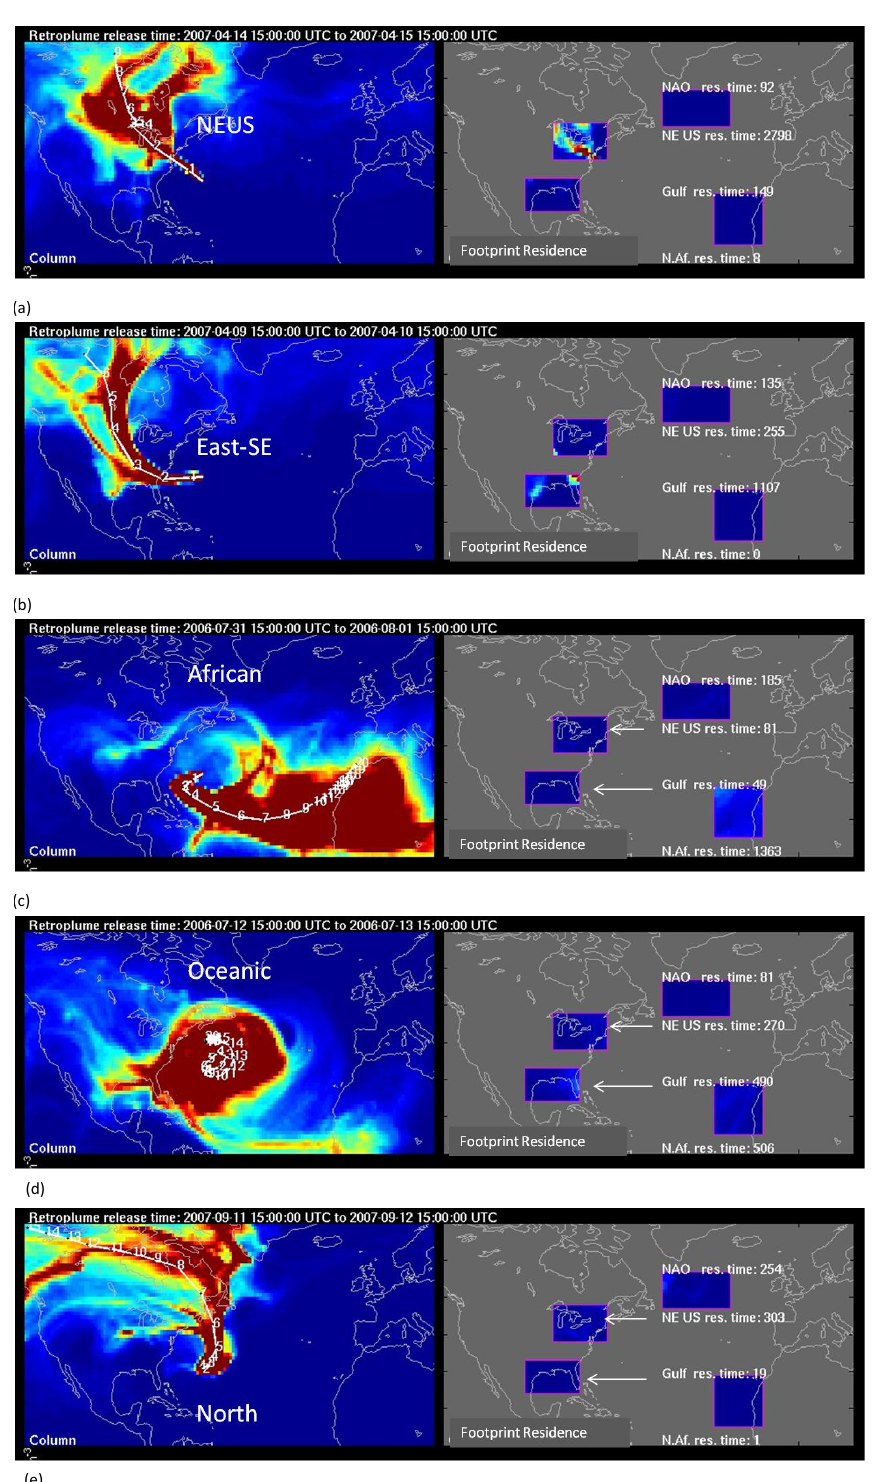
Fig. 1. Individual examples for each of the five aggregated source region flow patterns showing the column residence time for FLEXPART retroplumes (left panels) and the corresponding residence times in the four prescribed footprint source regions (NAO, NE US, Gulf, N.Af, in right panels) that were used to assign each day to a dominant source region delivering air to Bermuda: (a) NEUS on 21 to 22 April 2009, (b) East–SEUS on 9 to 10 April 2007, (c) African (AFR) on 31 July to 1 August 2006, (d) oceanic on 12 to 13 July 2006, and (e) North on 11 to 12 September